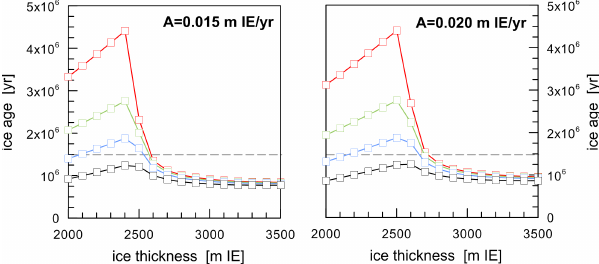
Fig. 2. Age of the ice at the bottom of the ice sheet for differ- ent ice thickness, but constant mean accumulation rate of A = 0.015mIEyr − 1 (left) and A = 0.02mIEyr − 1 (right) using a con- stant mean surface temperature of 213K and a geothermal heat flux of 55mWm − 2 . The colors indicate the age 10m above bedrock (red), 25m above bedrock (green), 50m above bedrock (blue), and 100,m above bedrock (black). The grey dashed line indicates the 1.5Myr age